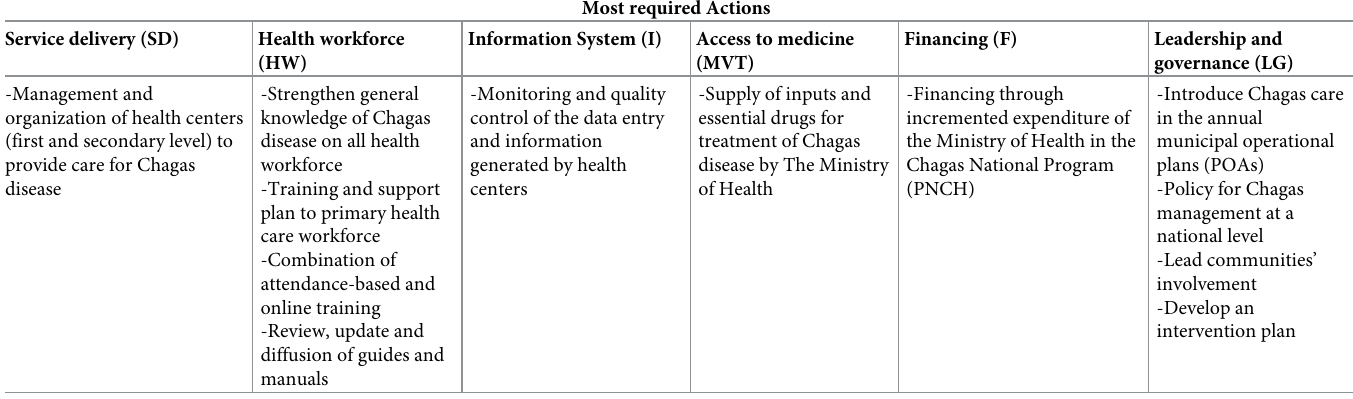
Table 1. Actions defined classified by building